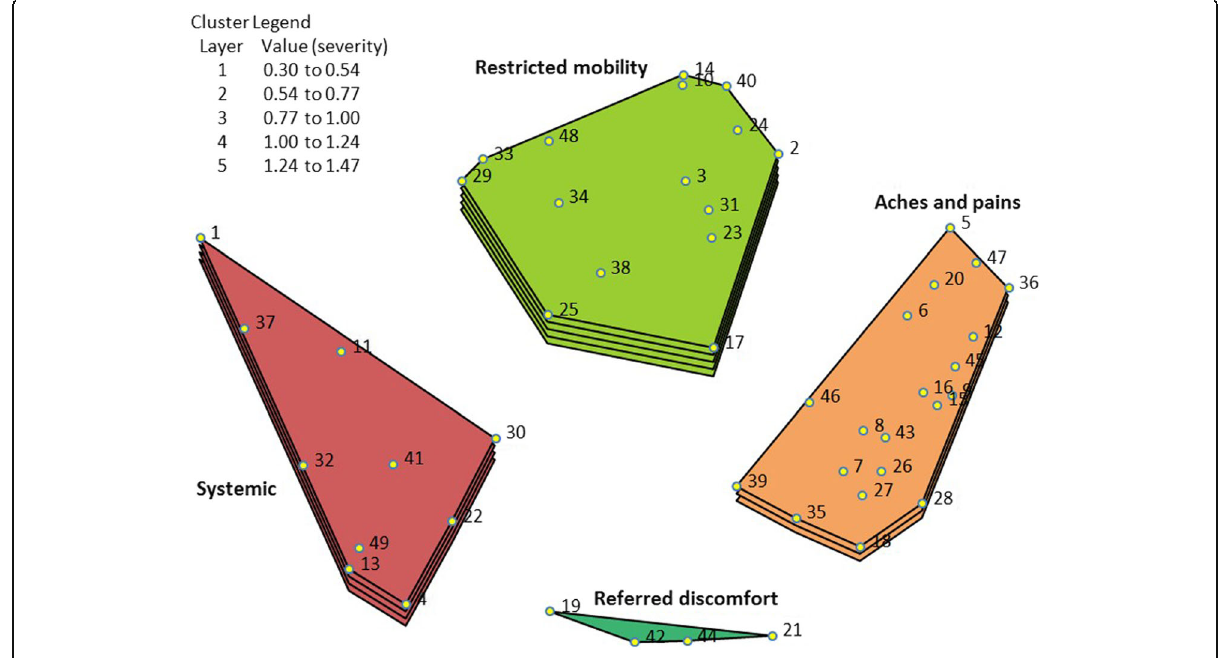
Fig. 4 3D map detailing the 4-cluster solution, rated at the domain level by